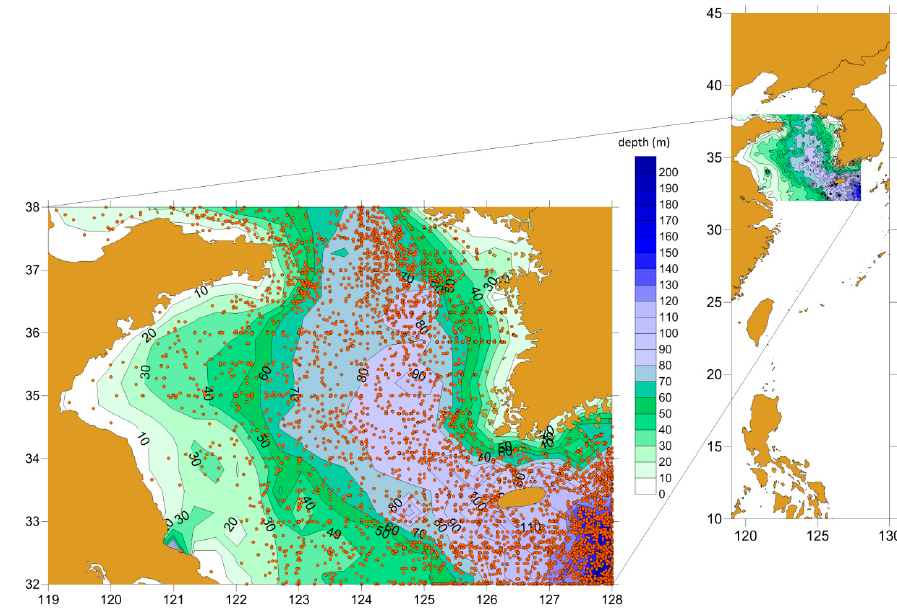
Figure 7. Bathymetry in the Yellow Sea.